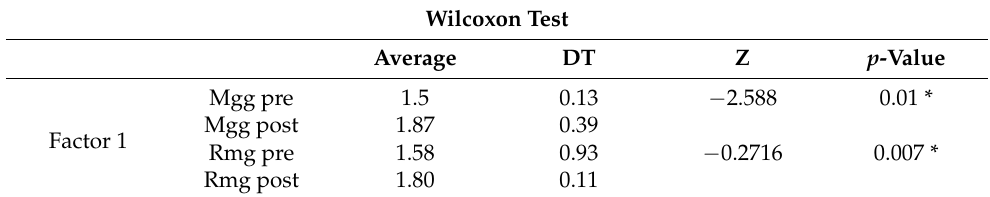
Table 2. Wilcoxon test applied to Factor 1 (Familiarization).